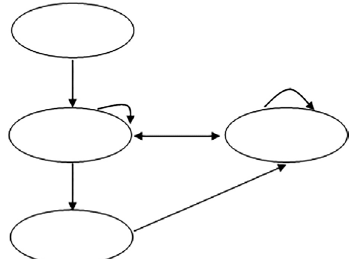
Fig. 4. ANP Network Conceptual Diagram Source : Saaty (1996)